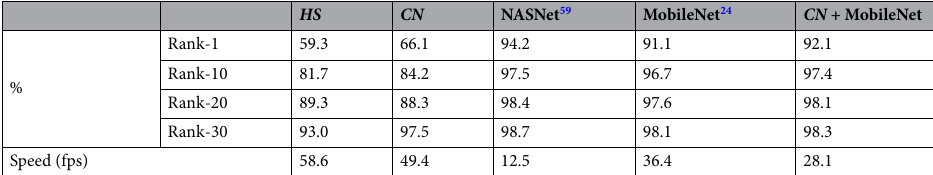
Table 2. Comparison of appearance and deep features (see “Experimental results” section for details). Correctly matched pairs over 600 pairs in a specific rank and execution speed. CN : Colour Naming; H Hue; S Saturation. CN + MobileNet has the best performance trade-off.